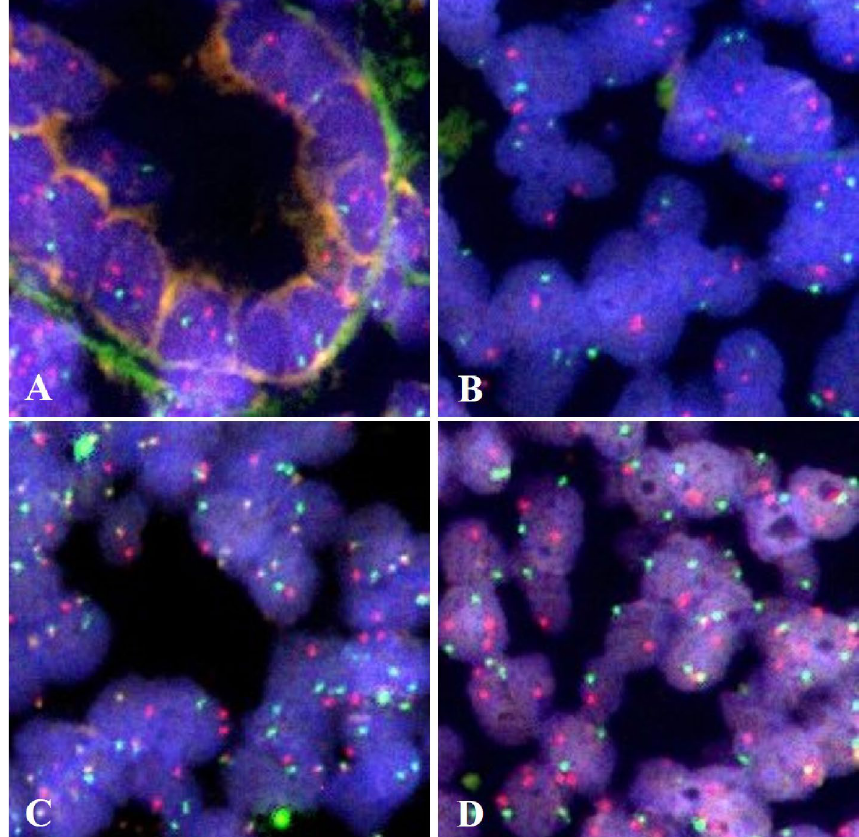
Figure 6. Dual-color interphase FISH analysis to detect chromosomal aberrations of 11q22 (BRIC3, green) and 18q21 (MALT1, orange) in MALT lymphomas. (A) Wild type signals in normal gastric gland (A) and in a case of MALT lymphoma with a low frequency of abnormal 53BP1 expression (Case No. 8 in Table 4) (B) . Translocation t(11;18)(q21;q21) signals (yellow) in a case of MALT lymphoma with a high frequency of abnormal type (Case No. 3 in Table 4) (C) . Trisomy of 18q21 (three orange and two green signals) in a case of MALT lymphoma with a high frequency of abnormal type (Case No. 2 in Table 4) (D) . The images were photographed with the Z-stack function of Biorevo BZ-X710 microscope (Keyence Japan, Osaka, Japan), and their signals were analysed using the image analysis software provided with the Biorevo